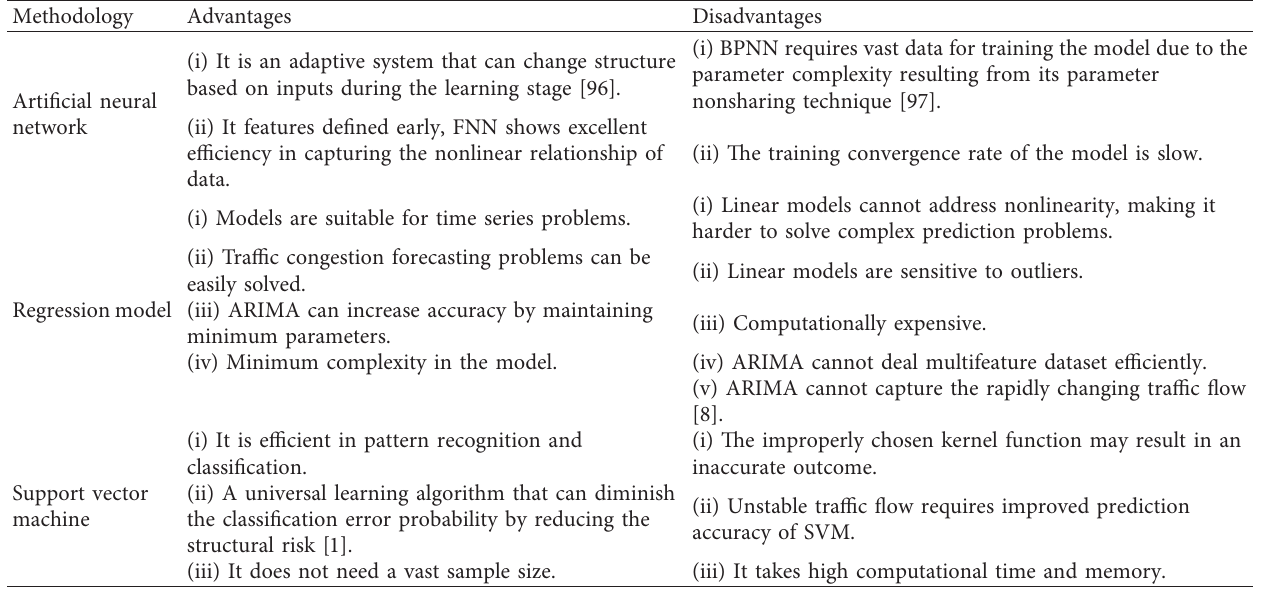
Table 5: The strength and weakness of the models of shallow machine Learning.